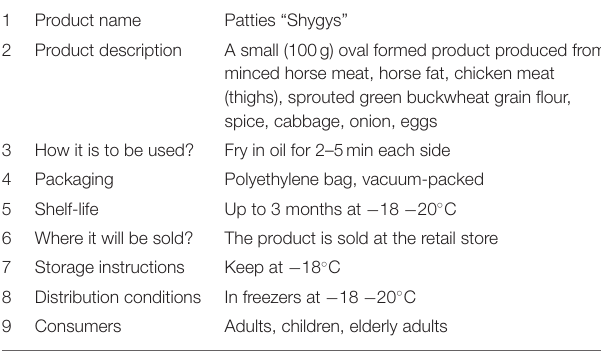
TABLE 2 | Product description of “Shygys”